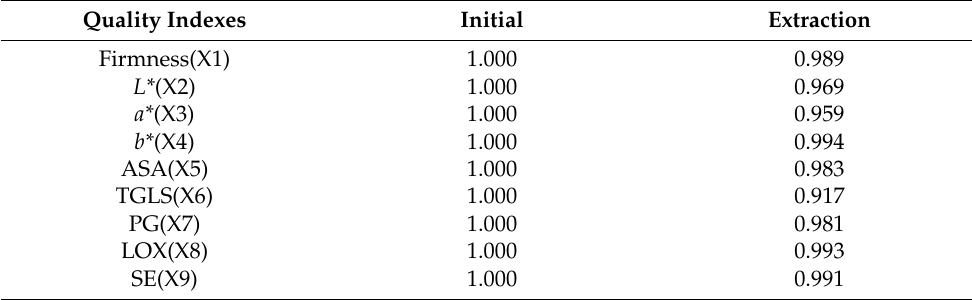
Table 4. Factor variance statistics of quality indicators.